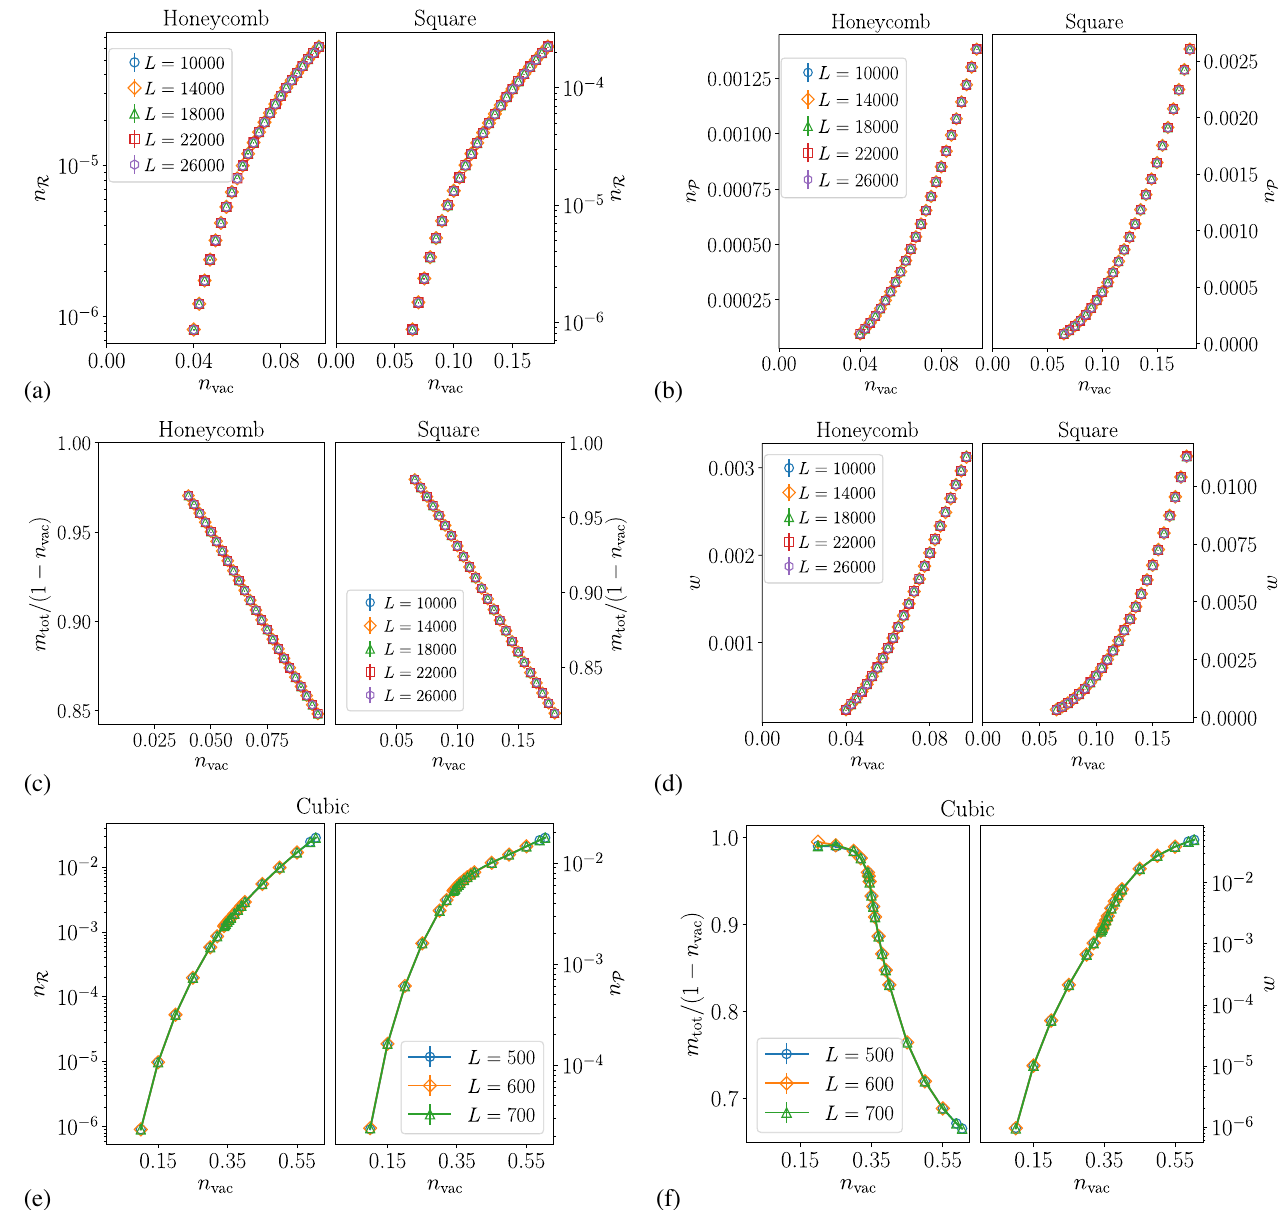
FIG. 5. (a,b,e) The mean number densities n R and n P of R -type and P -type regions are nonzero in the thermodynamic limit and → 0 ) limit of site-diluted honeycomb, square, and cubic lattices. (c,d,f) The decrease rapidly as we approach the low-dilution ( n vac sample-averaged total mass density of R -type regions, m , is nonzero in the thermodynamic limit and appears to tend towards 1 − n tot → 0 ) limit of site-diluted honeycomb, square, and cubic lattices. This density is normalized to the number of in the low-dilution ( n vac þ m þ m ¼ 1 in all three cases (here, m sites in the undiluted sample, so n P P is the corresponding sample-averaged total mass vac tot density of P -type regions). The sample-averaged density of zero modes, w , is also nonzero in the thermodynamic limit and goes rapidly to zero in the small- n limit. See Sec. VI for vac